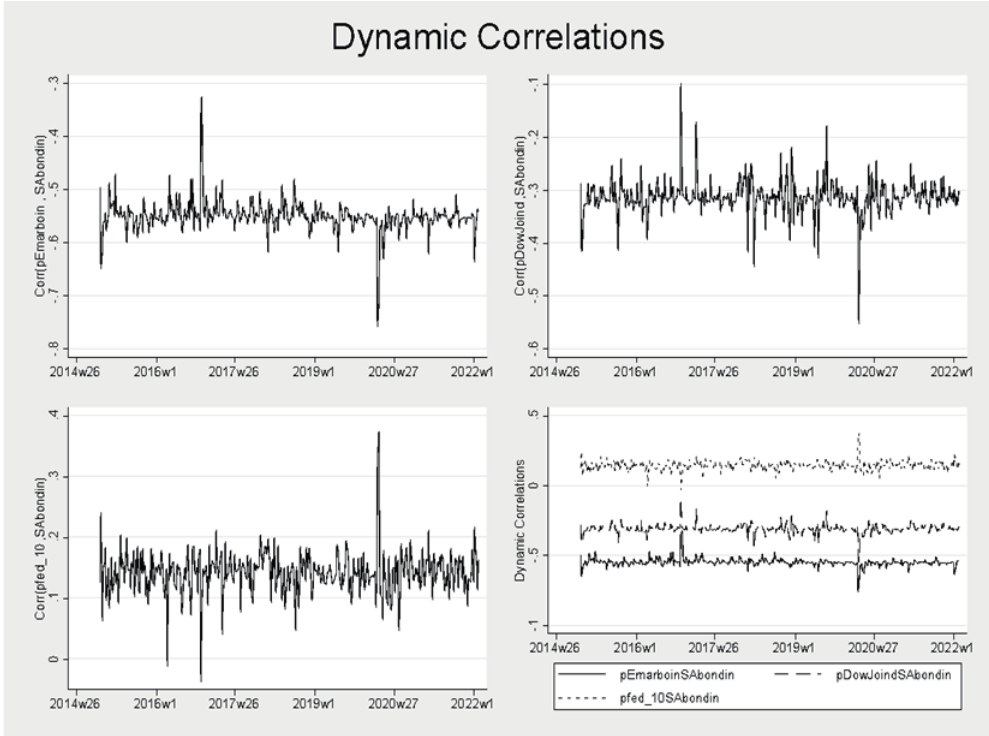
Fig. 3. DCC between the exogenous variables and South African sovereign bond return.